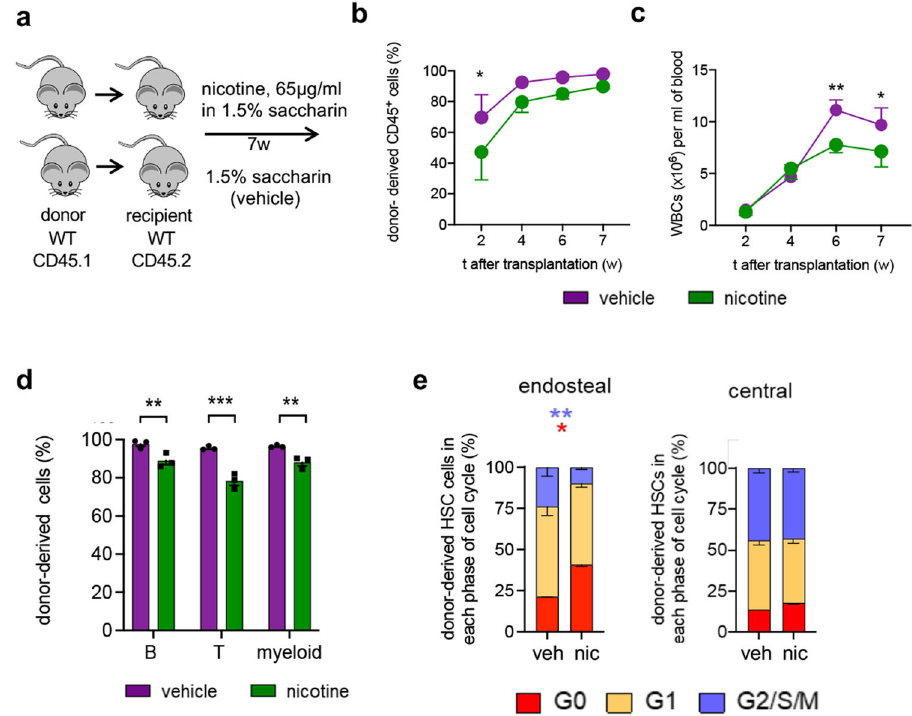
Fig. 7 Nicotine induces HSC quiescence after transplantation. a Scheme illustrating experimental design. Irradiated WT CD45.2 recipients were transplanted with 2 × 10 6 BM nucleated cells from CD45.1 mice and treated with 65 µ g/ml nicotine or vehicle in their drinking water over 7 weeks. b , c Circulating donor-derived (CD45.1 + ) haematopoietic cells ( b , P = 0.03) and white blood cells ( c , P = 0.006,0.04) at speci fi ed time after transplantation ( N = 3). d Donor-derived B cells ( P = 0.007), T cells ( P < 0.0001) and myeloid cells ( P = 0.009) from mice treated with nicotine or vehicle at 7 weeks ( N = 3). e Cell cycle pro fi les of donor-derived lin - sca1 + ckit + (LSK) CD34 - fl t3 - HSCs isolated from the endosteal or central BM 7 weeks after transplantation and chronic treatment with nicotine or vehicle ( N = 3 ;P = 0.005,0.04). ( b – e ) Data are mean of biological replicates ± SEM. * P <